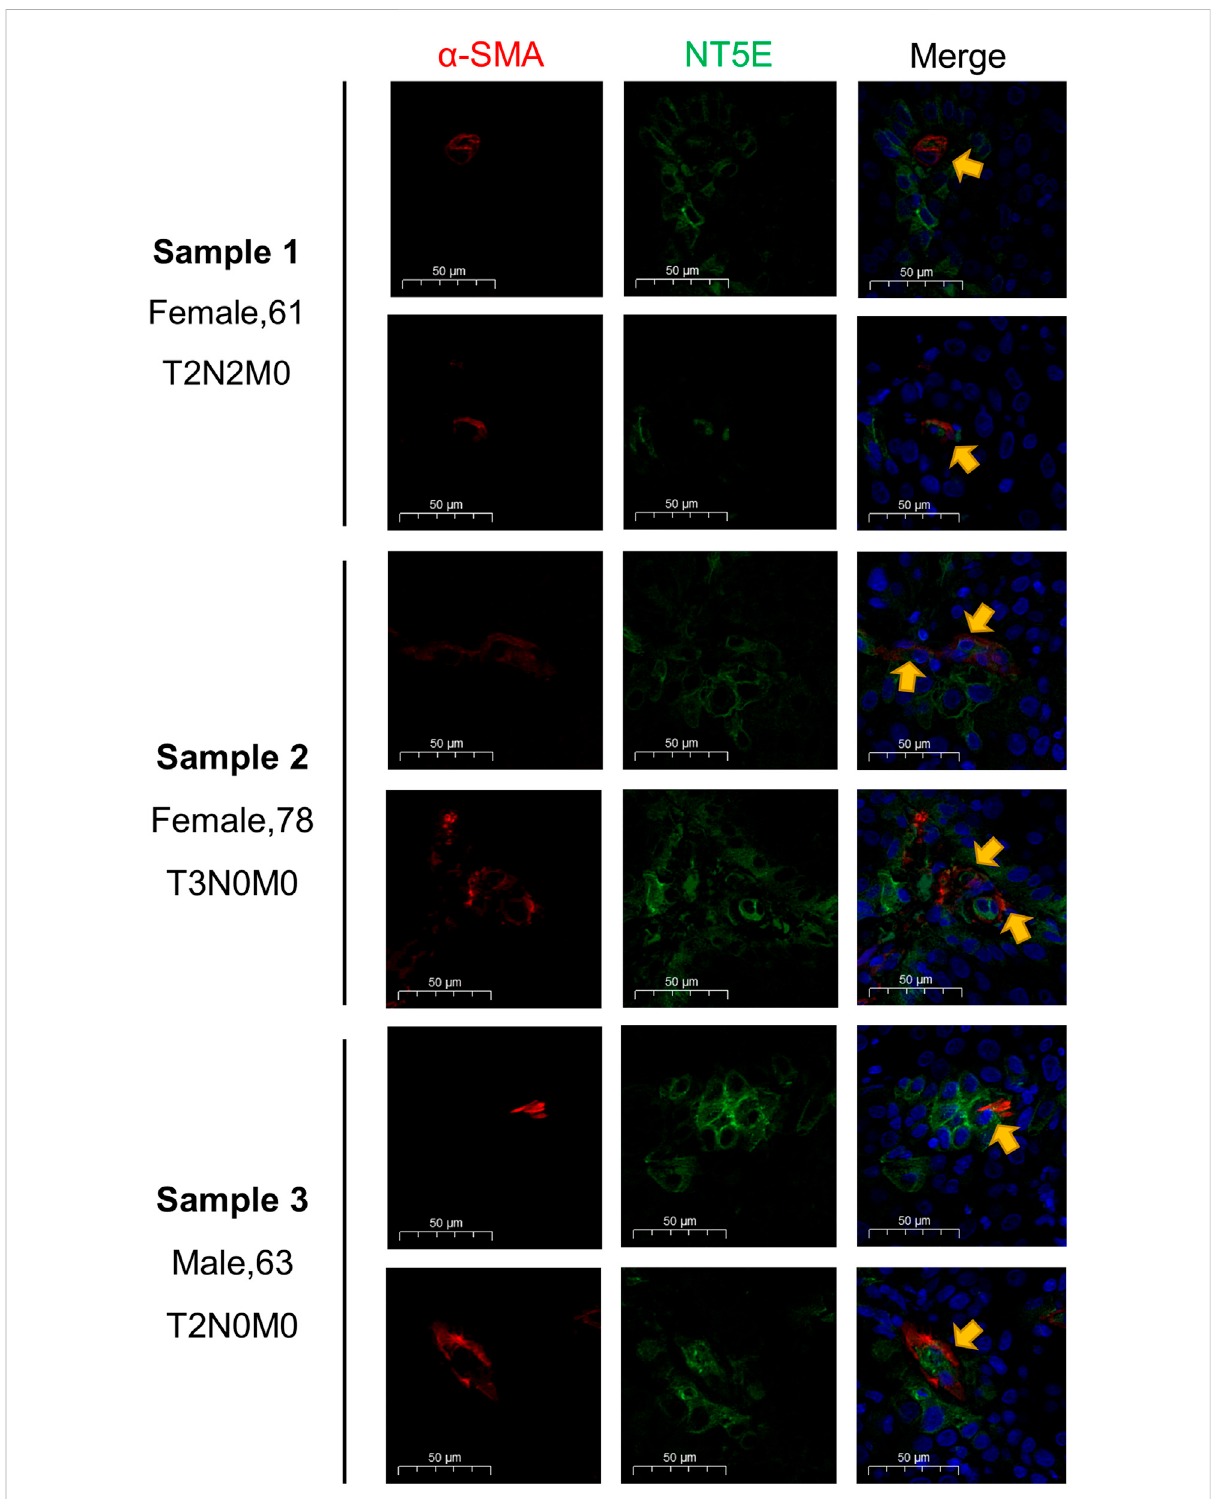
FIGURE 7 ValidationofNT5EexpressionpatternonthesupraglotticcarcinomaspecimenswithvariousTNM-staging.Scalebar=50 μ m.Redstandsfor α - SMA expression, green stands for NT5E expression, and blue stands for nuclear staining by